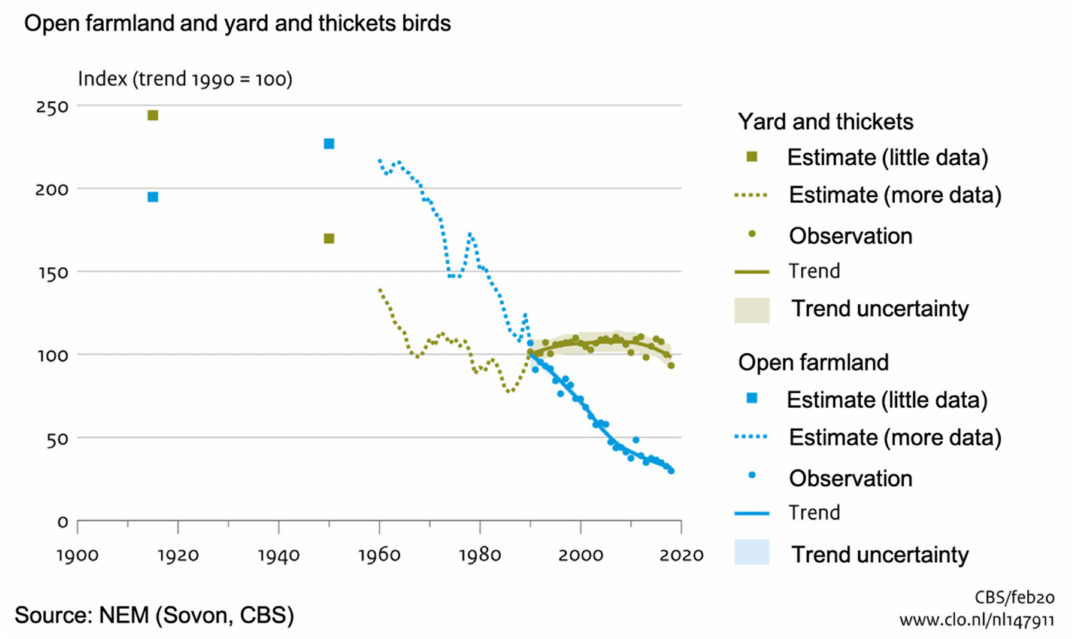
Figure 2. Trends in bird populations open farmland in The Netherlands (in blue) (adapted from: